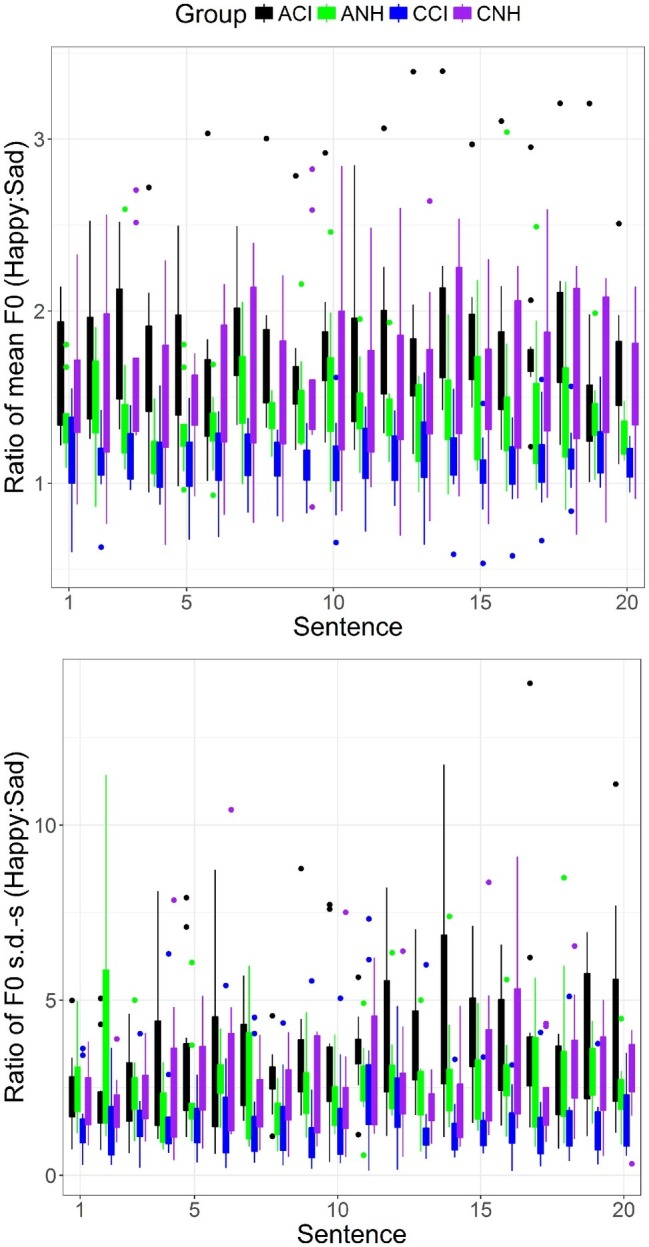
Boxplots of acoustic contrasts between happy and sad emotions for mean F0 (upper) and F0 s.d. (lower) for each sentence (abscissa) and for the four groups (see legend).